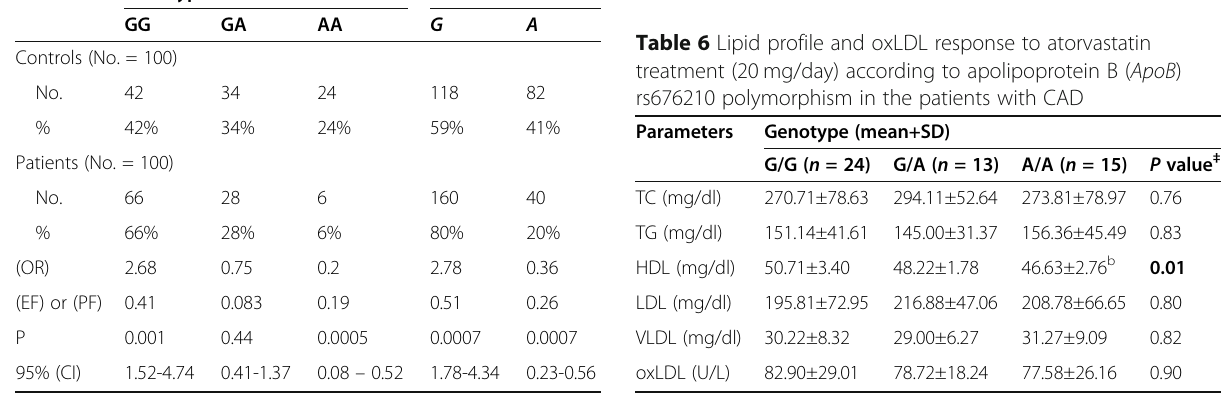
Table 6 Lipid profile and oxLDL response to